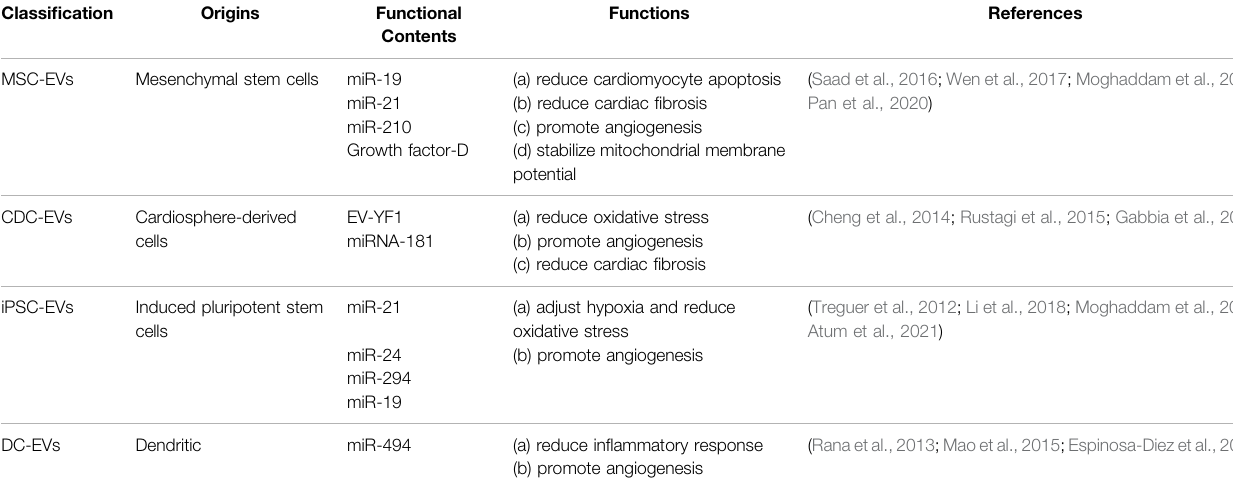
TABLE 1 | Origins and therapeutic application of stem cell-derived EVs in